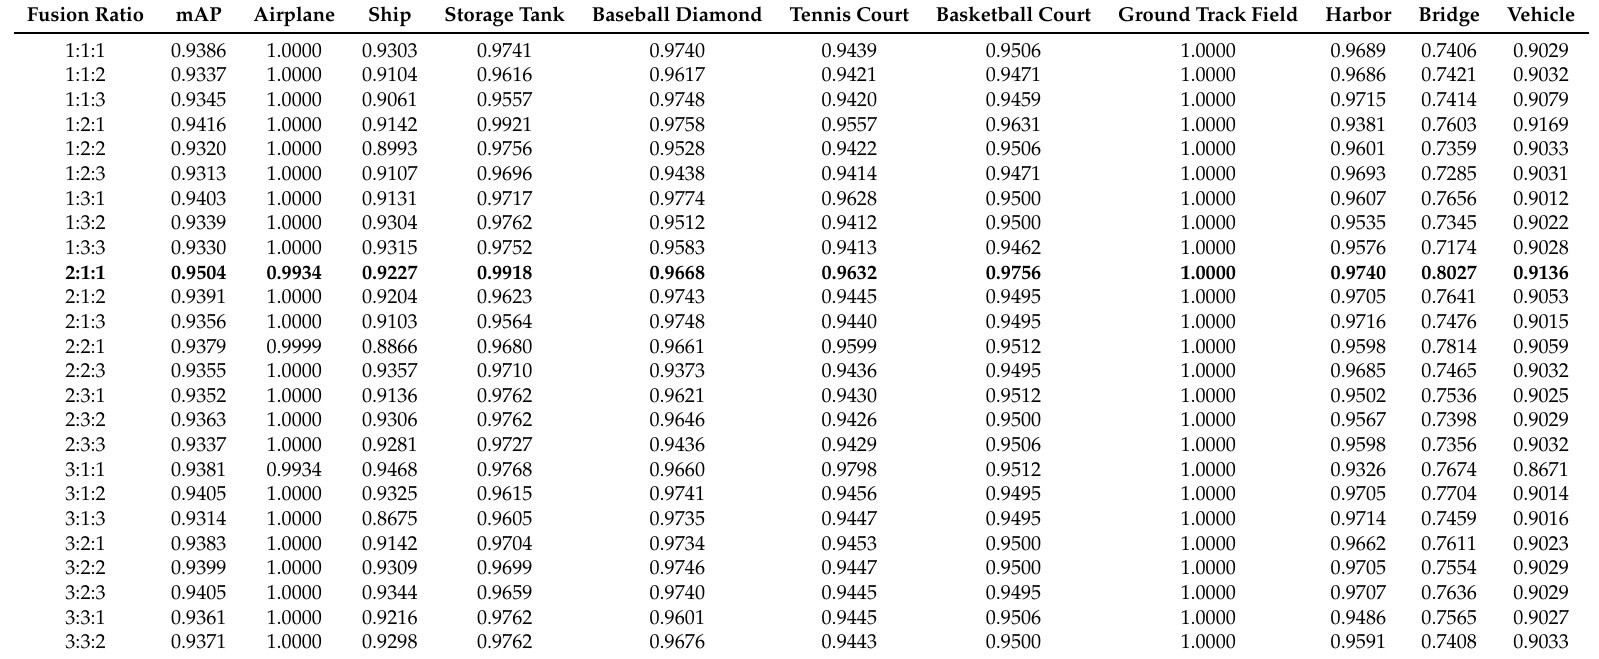
Table 2. Comparison detection results of 25 different decision fusion